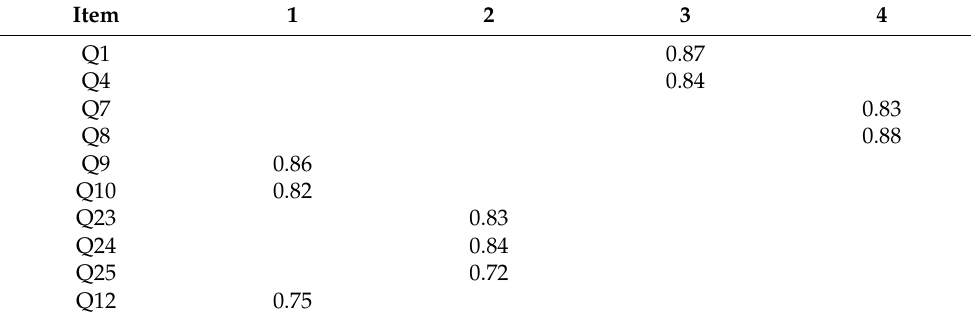
Table 1. Rotated component